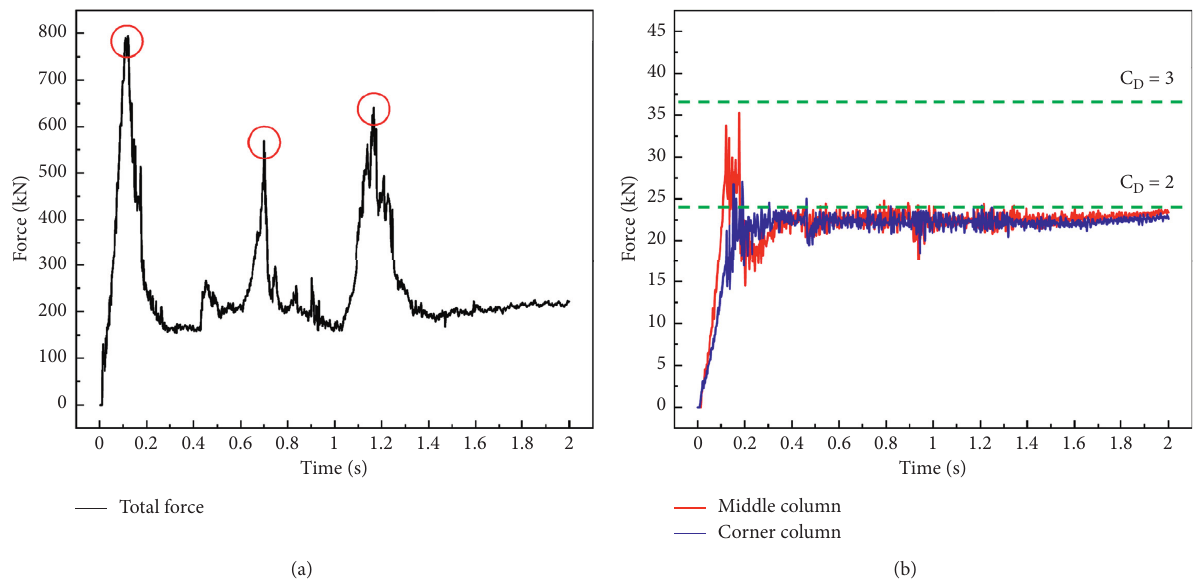
Figure 11: Impact force evolutions in the scenario of s � 1, h � 1.6 m, and v � 8.0 m/s in: (a) total building, and (b) the 1st-row columns (olive dotted lines representing calculated force value lines).